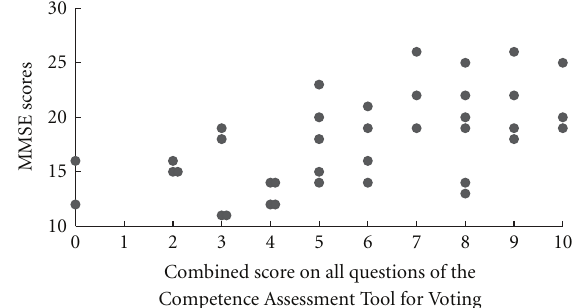
Figure 1: Relation of scores on the Mini-Mental Exam to combined scores on all questions of the Competence Assessment Tool for Voting ( r = 0 . 59, P < 0 . 0001).